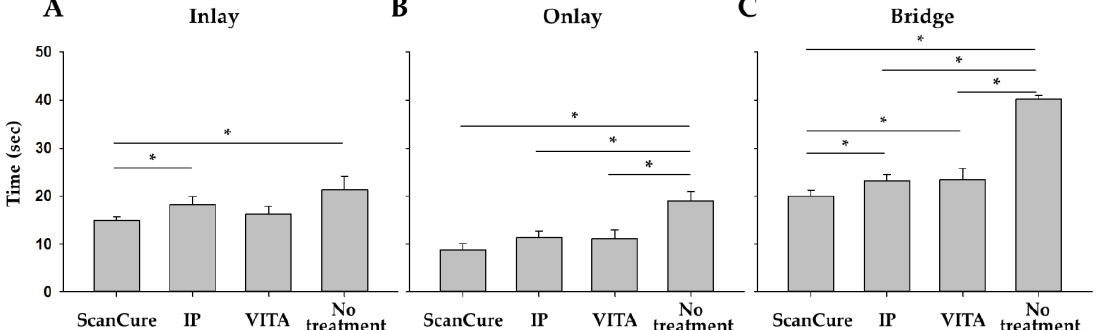
Figure 5. Bar graph of the working times for the four experimental groups (ScanCure, IP, VITA, No treatment, * p < 0.0083 by Bonferroni correction method) in three reference models. ( A ) inlay model, ( B ) onlay model, ( C ) bridge model.